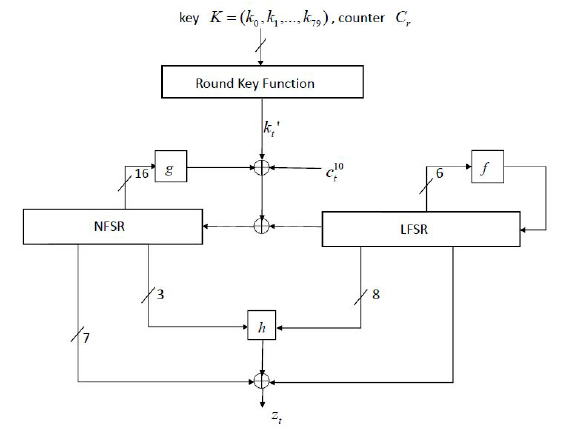
Figure 1: The keystream generation of